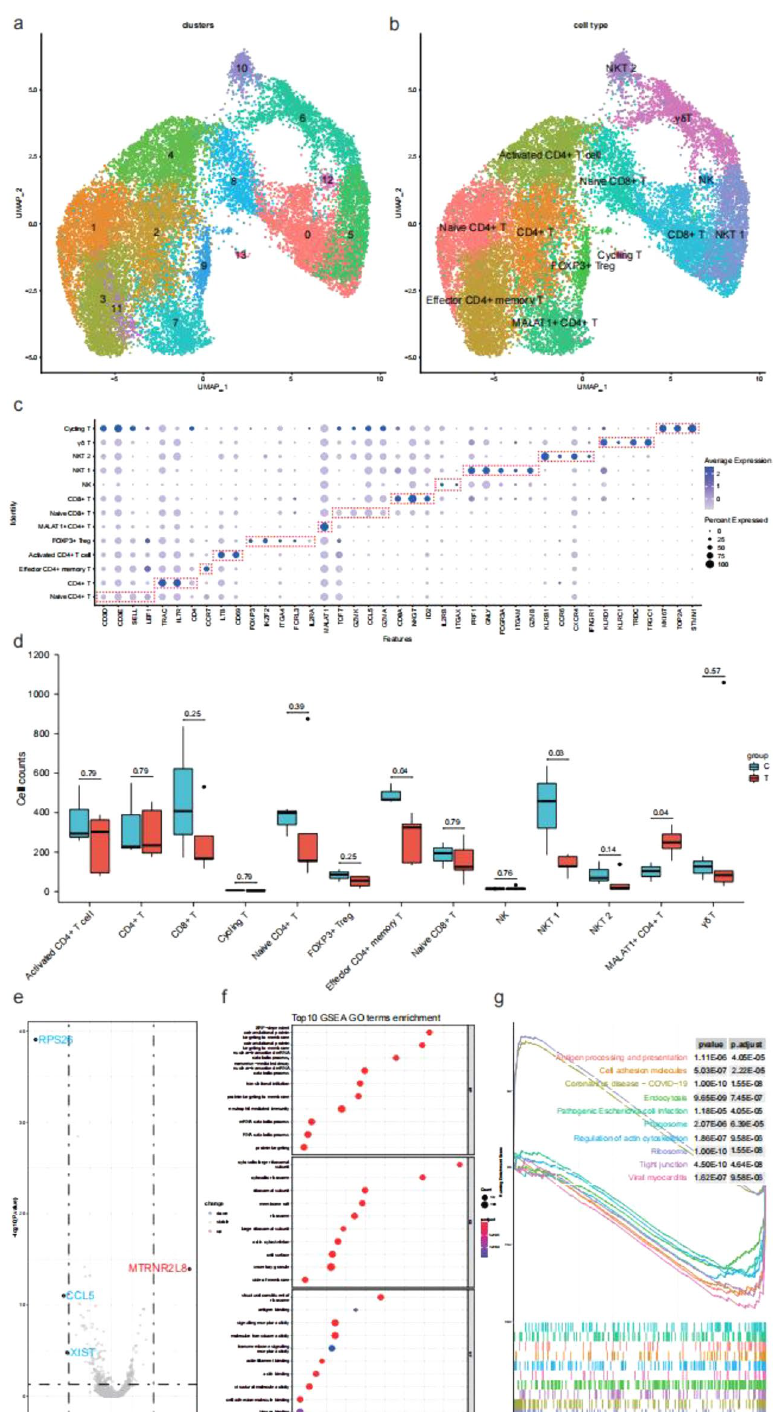
Figure 7. Landscape and characteristics of T cell subsets. ( a ) UMAP visualization of HC and AIDP patients T cell clusters. The color represents different clusters. ( b ) Cell annotation of HC and AIDP patients T cell clusters and visualization by UMAP. ( c ) A dot plot shows the expression of reference marker genes in T cell types, the plot color scale represents the average expression and the size scale represents the expression percent of selected marker gene transcripts in each cell type. The dots of each cell type specific genes are circled by red boxes. ( d ) Boxplots show proportions of each T cell type in HC and AIDP patients. The x axis correspond to cell types, the y axis correspond to cell counts. Wilcoxon rank-sum test is used to calculate two-sided P values between HC and AIDP patients, shown all P values. Horizontal lines represent median values, with whiskers extending to the farthest data point within a maximum of 1.5 × interquartile range. ( e ) A volcano of upregulated and downregulated DEGs between HC and AIDP patients in MALAT1 + CD4 + T cells. ( f ) GSEA-GO enrichment analysis in DEGs of MALAT1 + CD4 + T cells. A dot plot displays top 10 BP, CC and MF of GO terms according to adjust P value. ( g ) GSEA-KEGG enrichment analysis in DEGs of MALAT1 + CD4 + T cells. A GSEA enrichment plot displays top 10 KEGG pathways according to adjust P